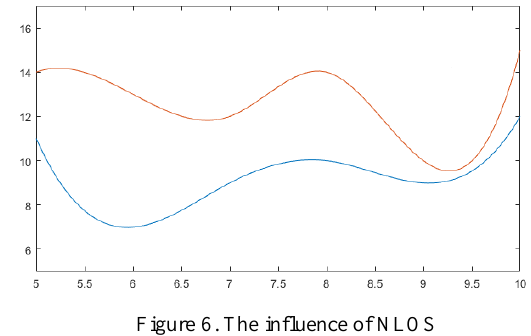
Figure 6. The influence of NLOS